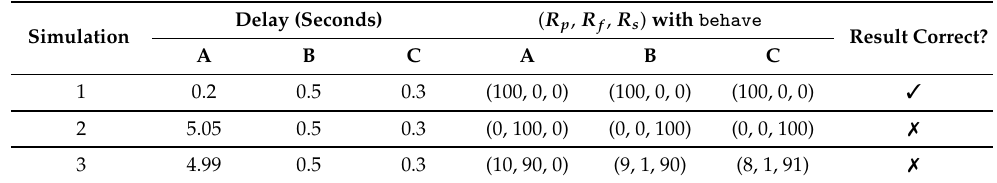
Table 2. Simulation results of executing the scheduled sprinkling specification in Figure 2 with behave , where R p , R f , and R s is the number of times the assertion passes , fails , or is skipped , respectively. Each simulation is repeated 100 times.